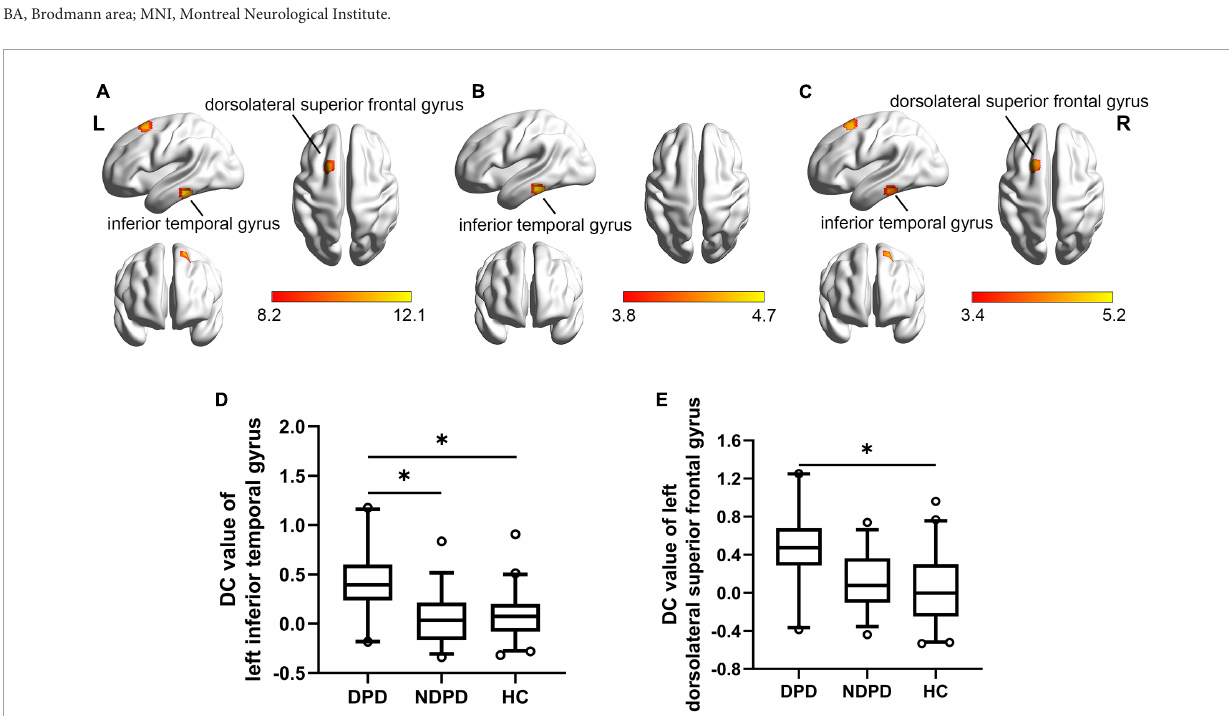
FIGURE2 Brain regions exhibiting significant differences in DC. (A) Group comparisons of the DC among DPD, NDPD, and HC groups. The color bar represents the F value of ANCOVA. (B) Post hoc analysis of DPD vs. NDPD. The color bar indicates the T -value from the two-sample t -test within the ANCOVA result masks. (C) Post hoc analysis of DPD vs. HC. The color bar indicates the T -value from the two-sample t -test within the ANCOVA result masks. (D,E) Box-and-whiskers plots for the DC value of left inferior temporal gyrus and left dorsolateral superior frontal gyrus in DPD, NDPD, and HC groups. The boxes display the median and the 25th and 75th quartiles, whiskers showing the 5th and the 95th percentile. The outlier is shown as a data point outside of the box. ∗ Post hoc P -value < 0.05, Bonferroni corrected. L, left; R,